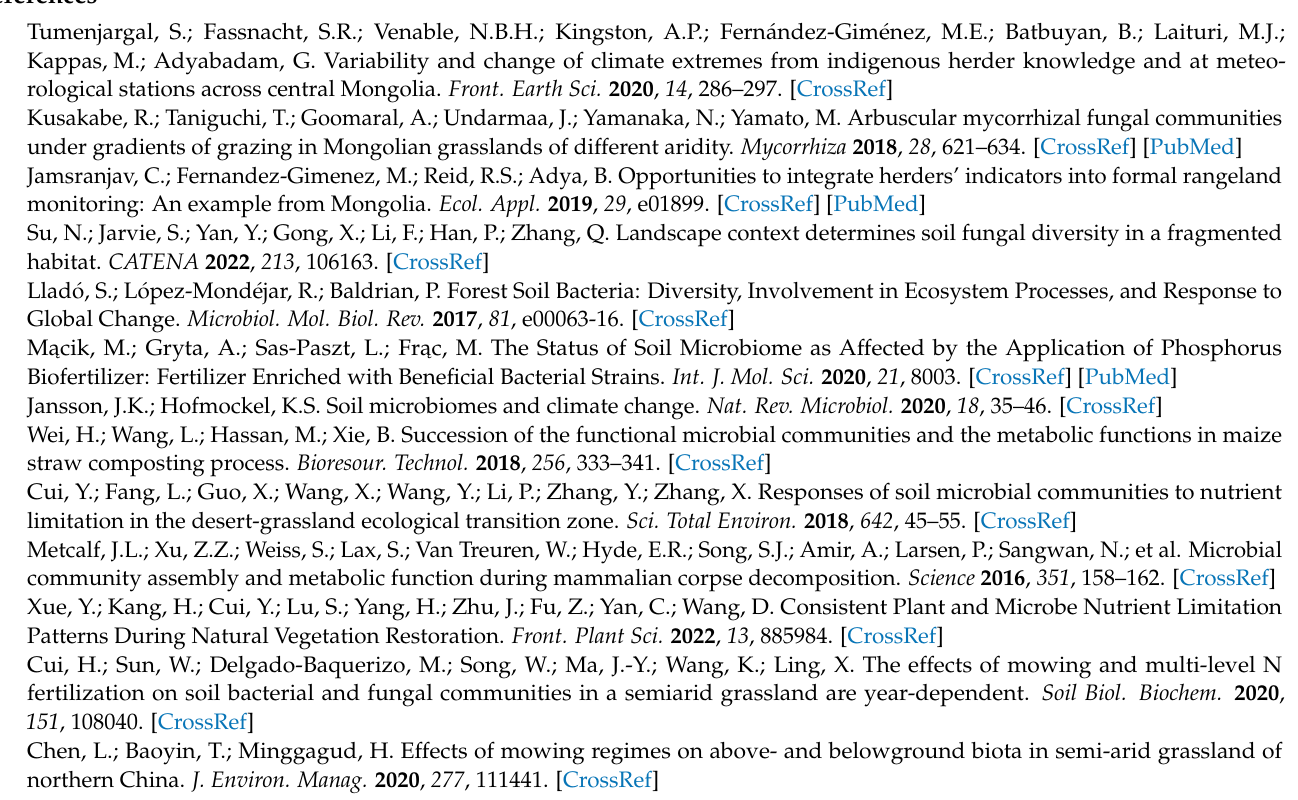
Table S2: Alpha-diversity indices of the soil microbial community in sampling